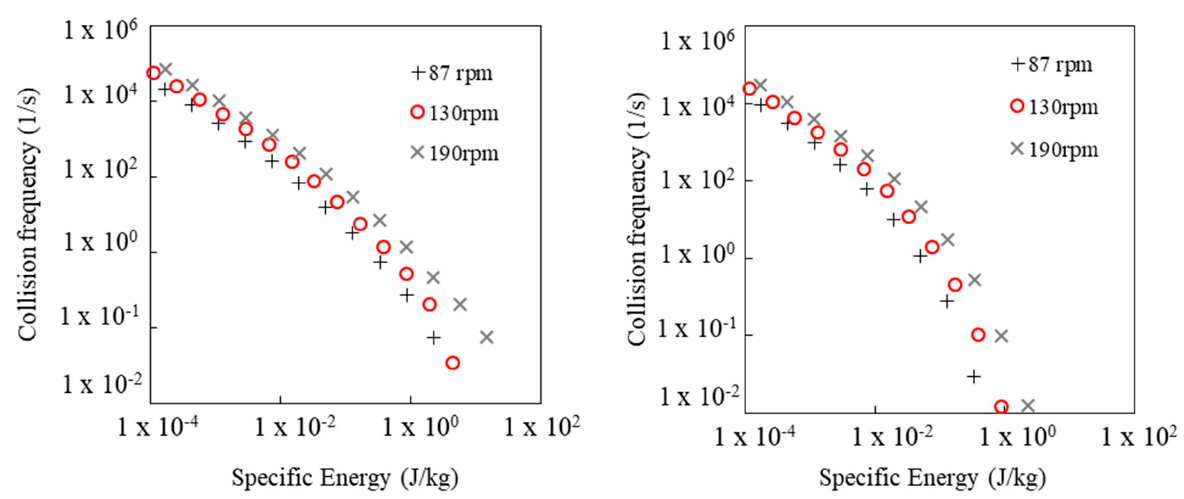
Figure 13. Particle collision spectra for normal (left) and shear (right) contact at different operational velocities.